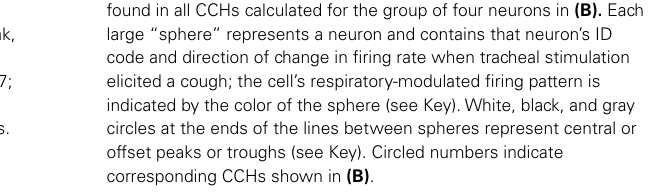
FIGURE 7 | Continued and target neuron spikes for each CCH are as follows: 1 : central peak, 15.0, 4.0ms, 55,253, and 92,800; 2 : offset trough, 4.1, 1.0ms, 92,800, and 51,671; 3 : offset trough, 5.0, 2.5ms, 92,800, and 57,087; 4 : offset peak, 4.3, 0.5ms, 51,671, and 57,087. (C) STAs of contralateral phrenic nerve activity. Bin width for both STAs = 0.5ms. a : Neuron 57, peak (lag to peak = 7.5ms). b : Neuron 55, dip (lag to nadir = 6.0ms). (D) Correlation linkage map summarizing features